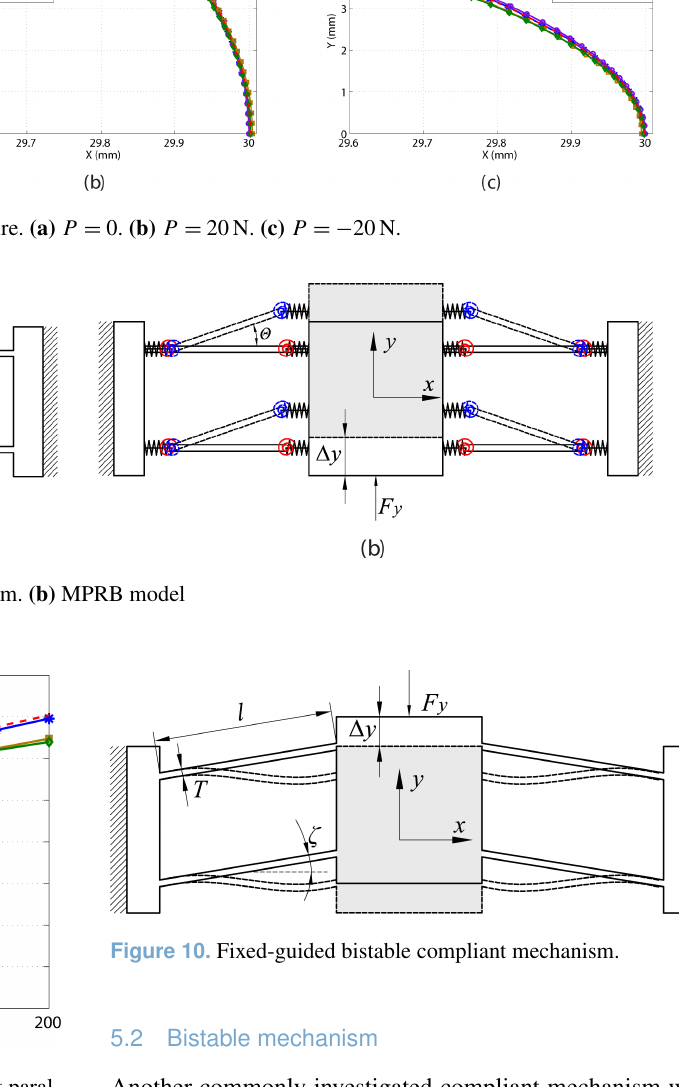
Figure 9. Output displacements of the compound compliant paral- lelogram mechanism.